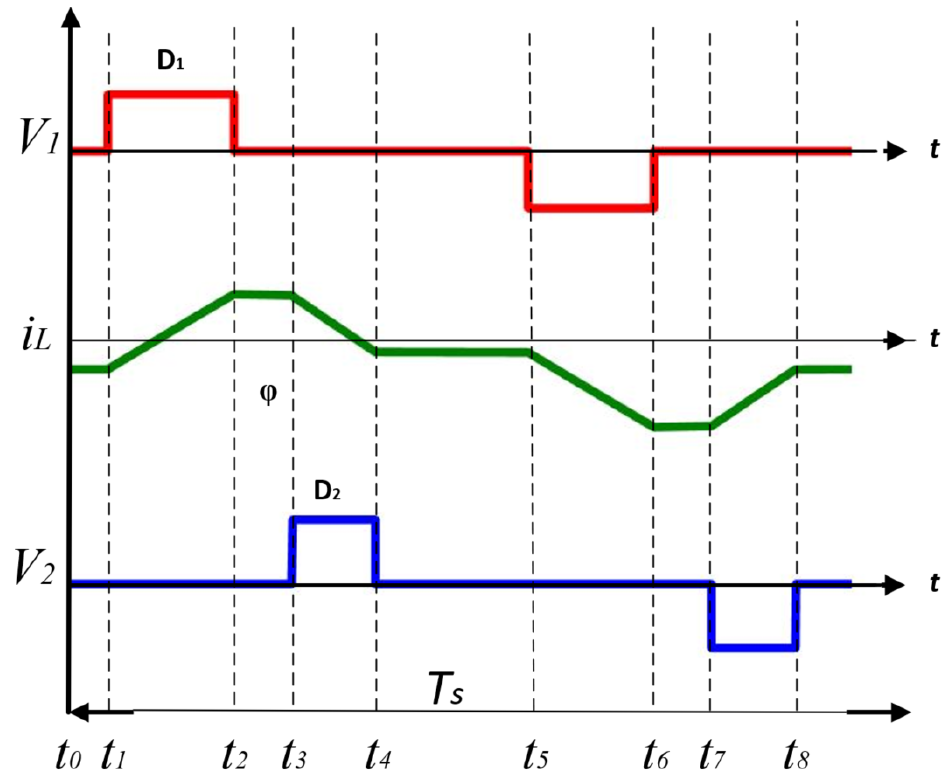
Figure 5. Primary and secondary voltages, and current under the TPS modulation method for